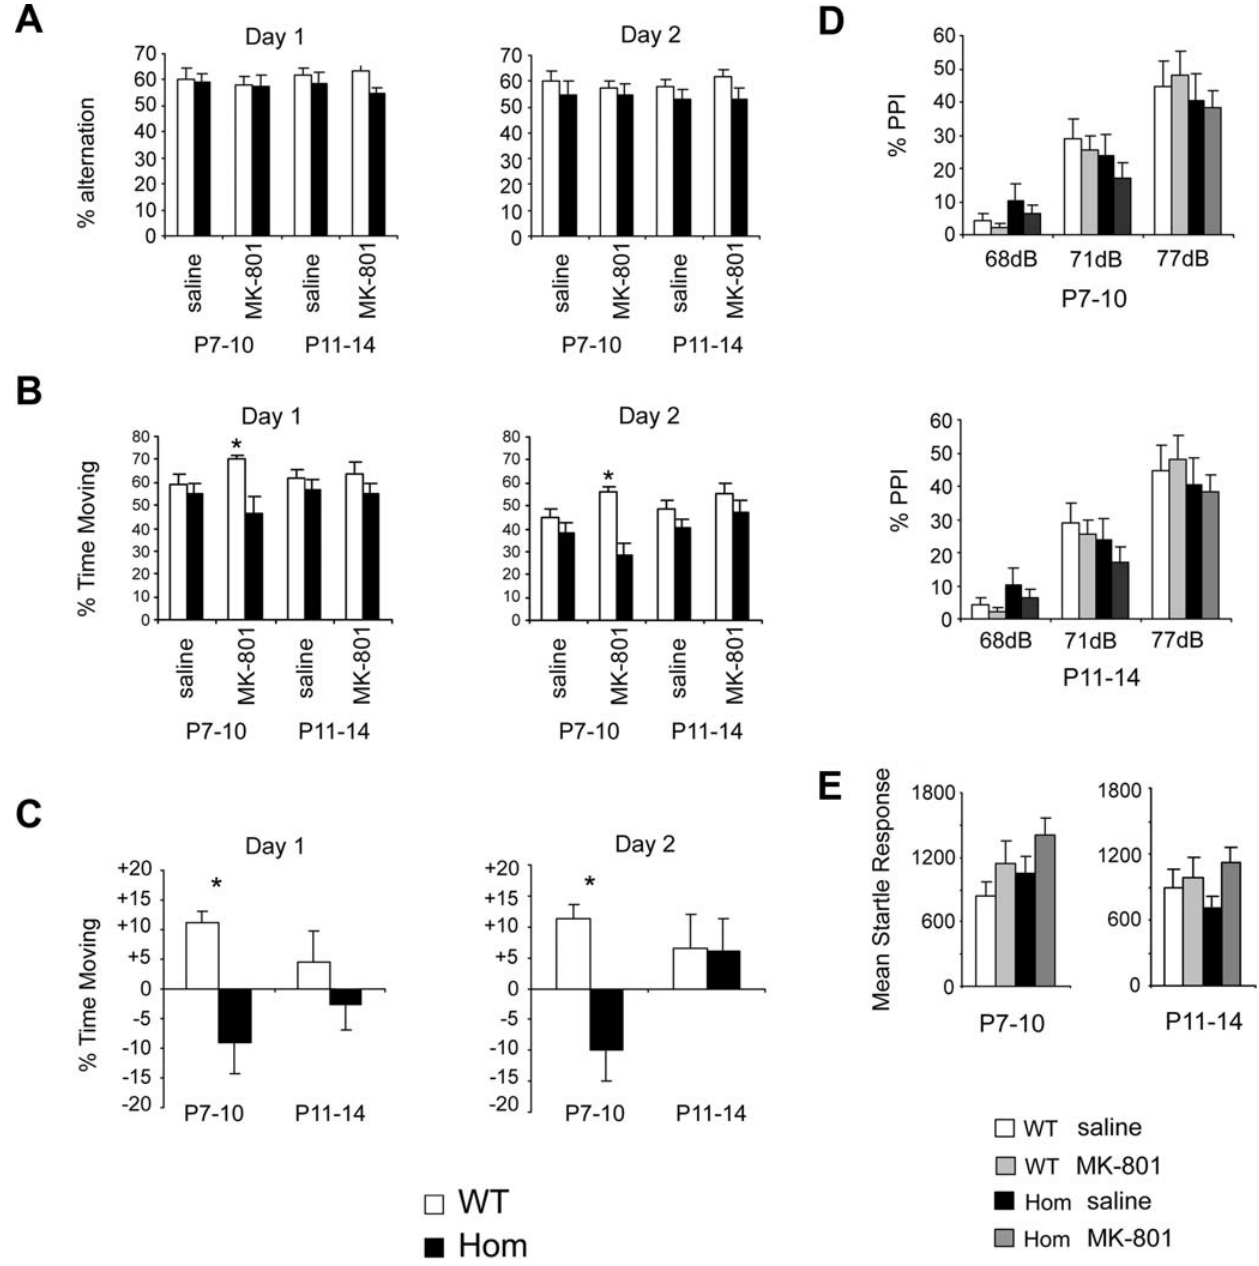
Figure 4. Behavioral characterization of adult Rtn4r-deficient mice following transient postnatal NMDAR blockade. (A, B) Percentage of alternation (A) and % time moving (B) observed in an 8-min session of a Y-maze spontaneous alternation assay, repeated over 2 days. Animals were injected with MK-801 or saline for 4 consecutive days during either P7–10 or P11–14; behavioral testing was conducted at P62 and P63. (C) Relative effect of MK-801 injection normalized to saline injection on time spent moving. (D) Average percentage of PPI (measured at P91) in animals injected during either P7–10 or P11–14. (E) Mean startle response to a 40 ms, 120 dB acoustic stimulus in animals injected during either P7–10 or P11–14. Startle response was measured at